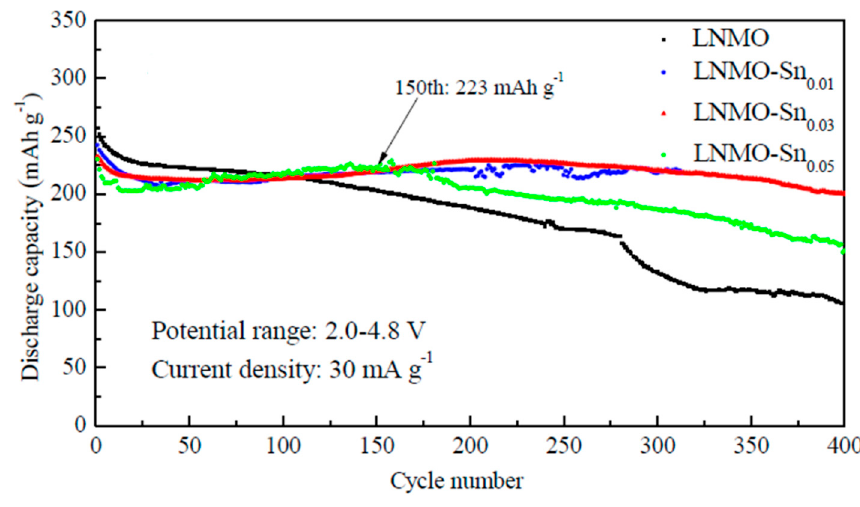
Figure 2. Cycling performance of LNMO, LNMO-Sn 0.01 , LNMO-Sn 0.03 , and LNMO-Sn 0.05 samples at 30 mA·g − 1 . Republished with permission of The Royal Society of Chemistry from [129]; permission conveyed through Copyright Clearance Center, Inc.